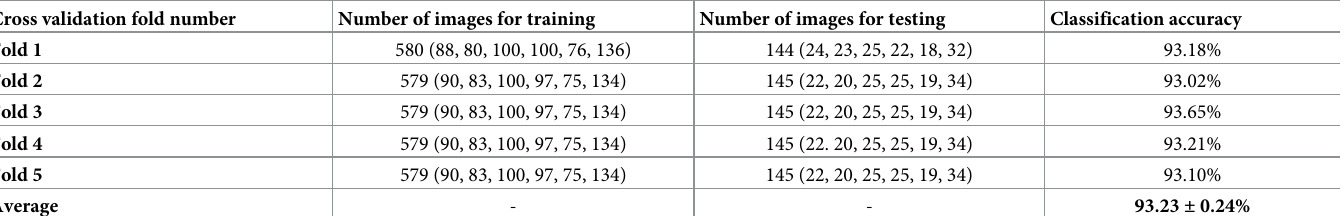
Table 13. Accuracy and number of images of each fold for the 5-fold cross validation using the 724 real hESC images. The number in the brackets indicates the num- ber of images per class for Cell clusters, Debris, Unattached cells, Attached cells, Dynamically blebbing cells, and Apoptically blebbing cells respectively. Cross validation fold number